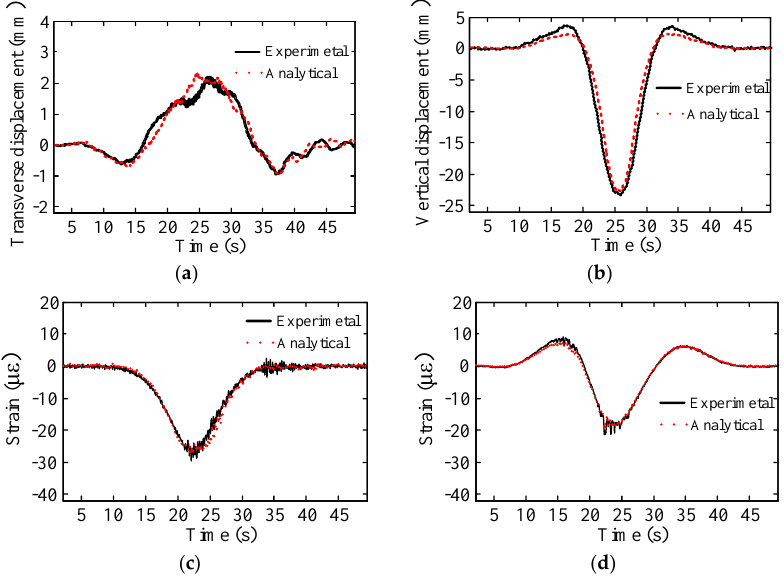
Figure 6. The comparison of test and numerical results with one train running through the bridge at a speed of 60 km/h: ( a ) the track beam in middle span ; ( b ) the track beam in middle span; ( c ) the vault; ( d ) the skewback.